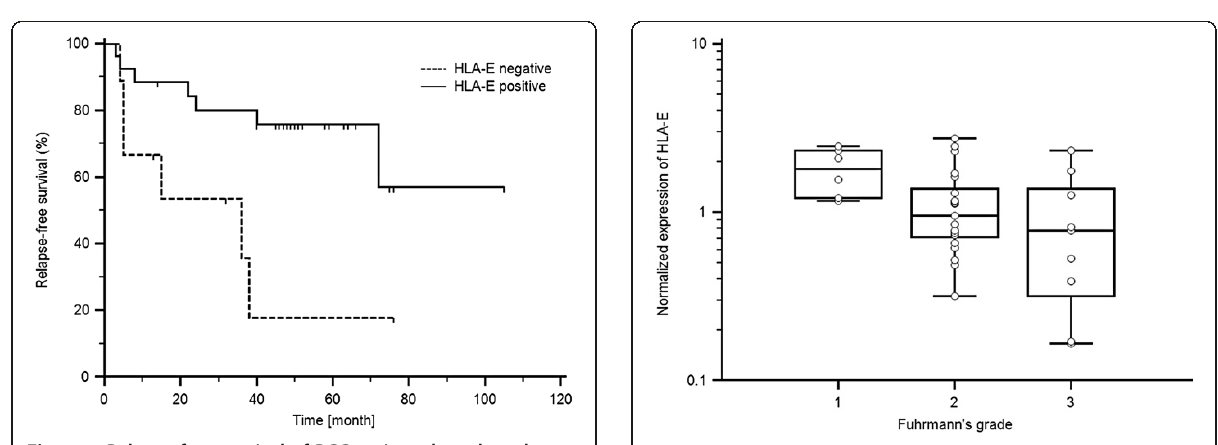
Figure 6 Correlation of HLA-E expression with Fuhrmann ’ s grade of RCC (p=0.0423, Kruskal-Wallis